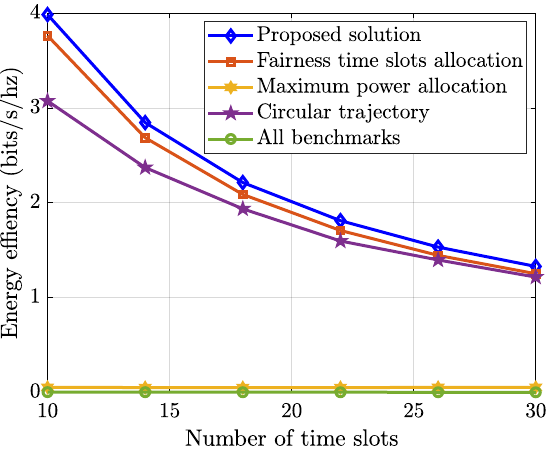
Figure 7. Maximum EE versus number of time slots comparing the proposed solution to other benchmarks when N = 5, L = 10 : 4 : 30.